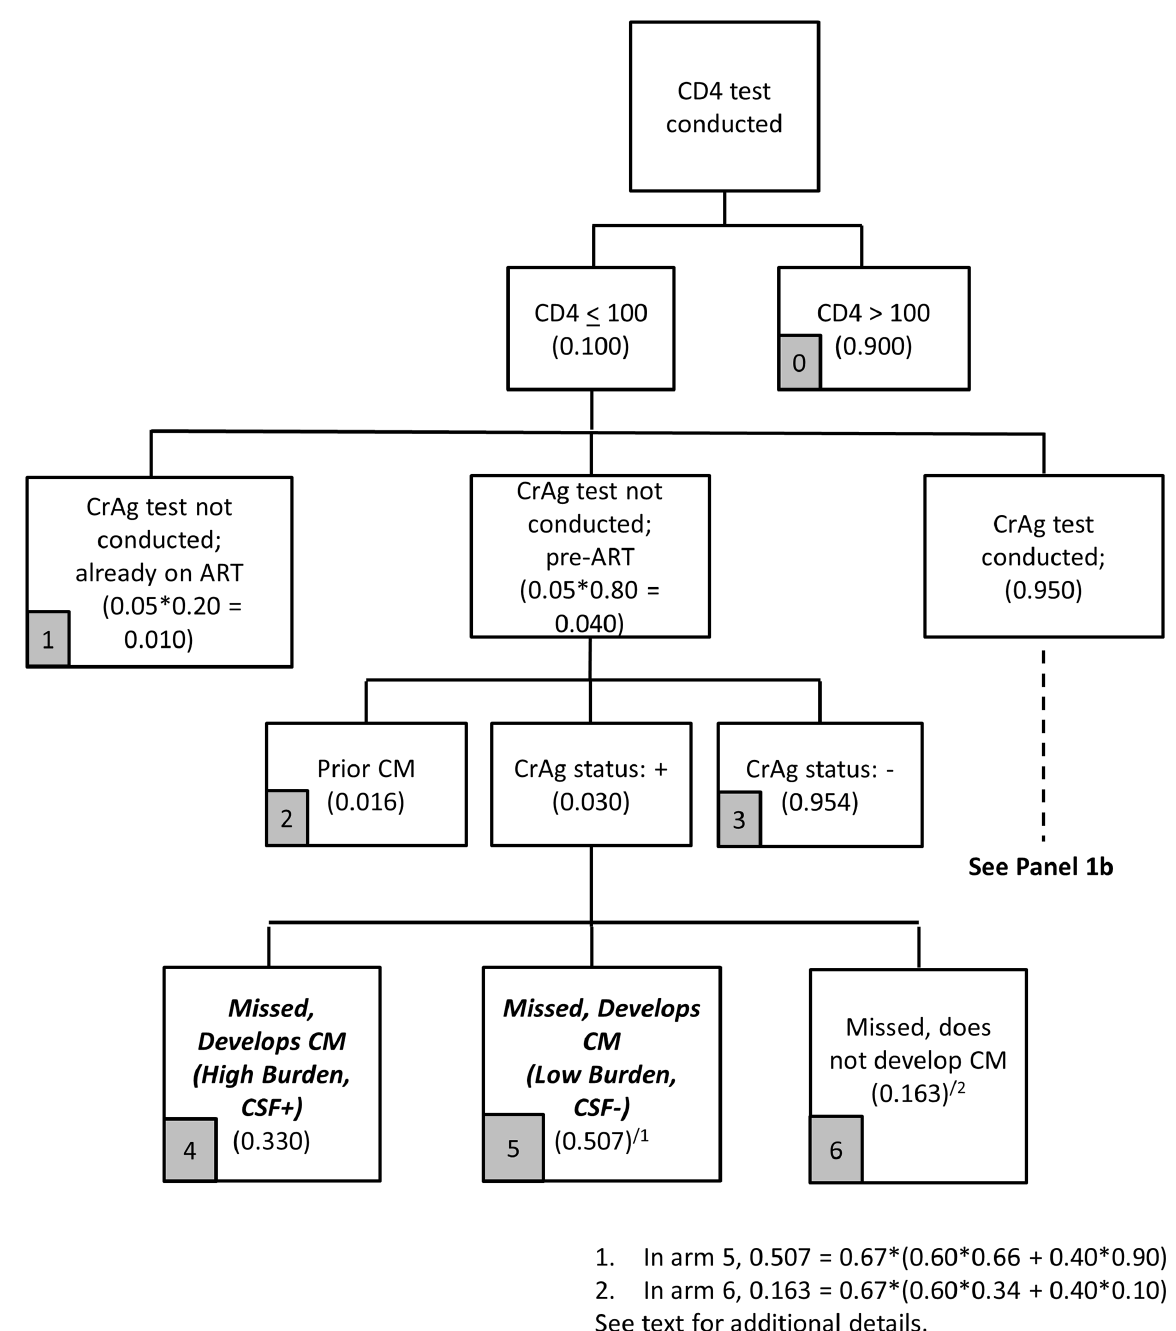
Fig 1. Reflex screening flowchart (Panel